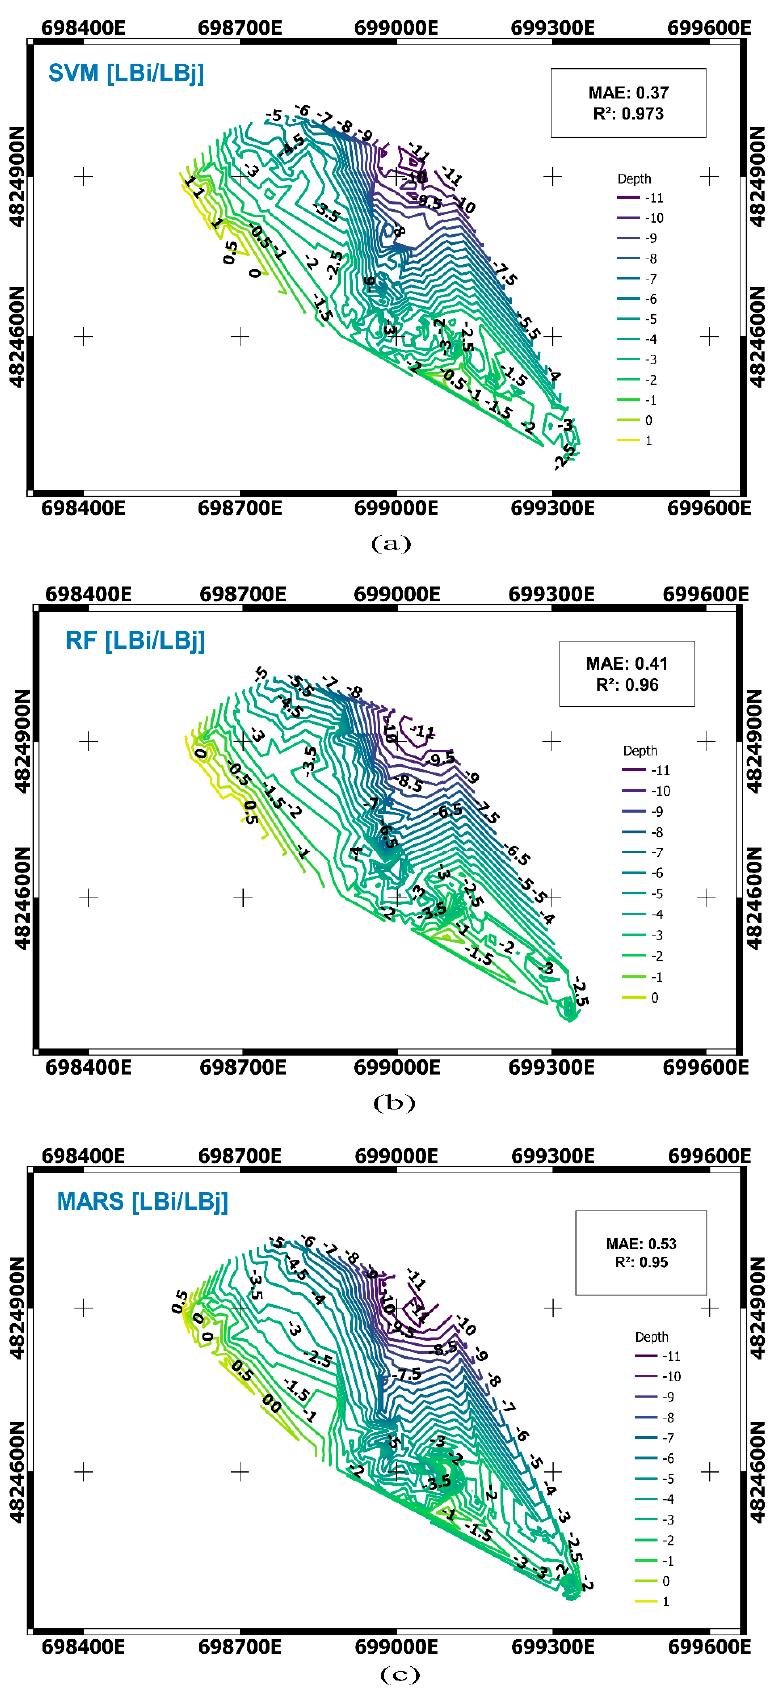
Figure 11. Comparison of water depth maps of Luarca obtained using different algorithms ( a ) SVM, ( b ) RF and ( c ) MARS, using bands as input variables. The color indicates the depth in meters.